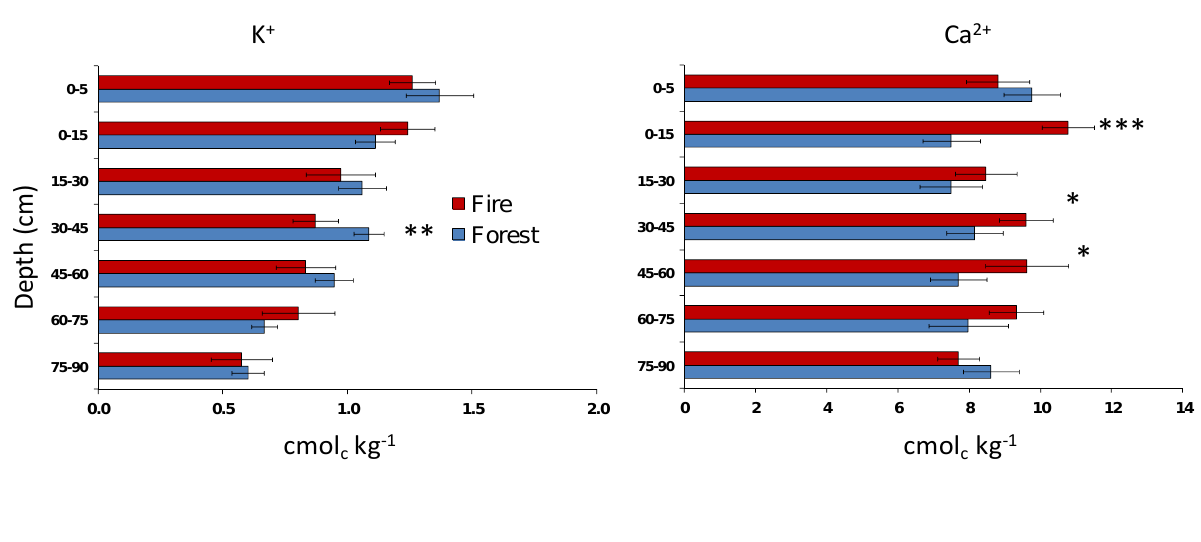
Figure 3. Exchangeable K + , Ca 2+ , Mg 2+ and extractable SO 42 − in the Sagehen soils. *, ** and *** indicate statistically significant differences, student’s t -test on log transformed data. Standard errors are